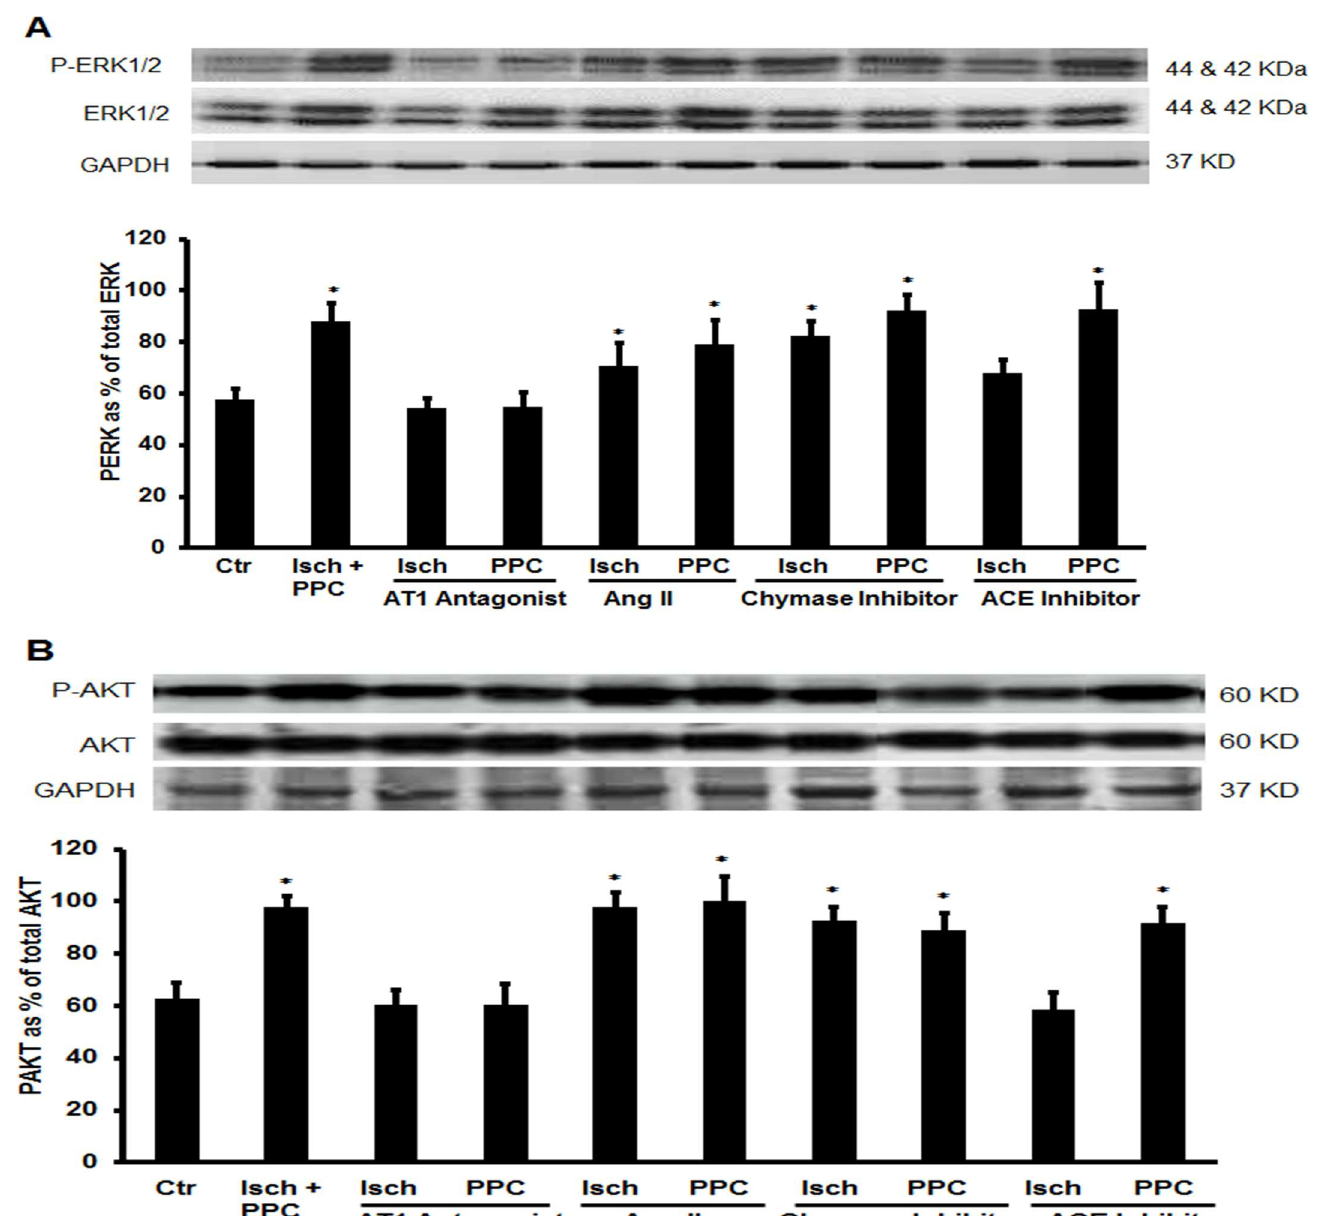
Fig 5. The effect of ACE-Chymase-Ang II-AT1 signaling and PPC on the RISK pathway. (A) Immunoblotting of P-AKT and (B) P-ERK1/2 expressed relative to total AKT and EKR1/2, respectively. Data is presented as mean ± SEM. Ctr, control; PPC, pacingpostconditioning. * P < 0.05 compared to the untreated